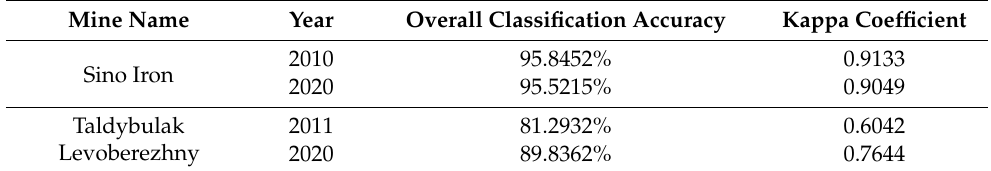
Table 2. Accuracy